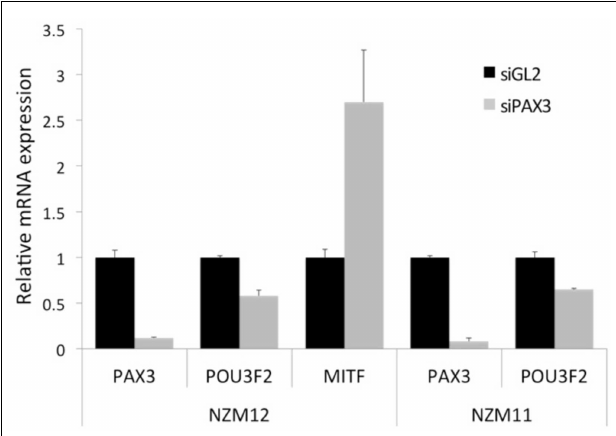
FIGURE 5 | Knockdown of PAX3 results in a decrease of POU3F2 and an increase of MITF gene transcript levels in melanoma cell lines in vitro . Transcript levels of PAX3 , POU3F2 , and MITF mRNA were examined by RT-qPCR in NZM12, and in NZM11 ( PAX3 and POU3F2 only) melanoma cell lines following RNAi treatment of the cell lines with either siRNAs against luciferase (siGL2) as a negative control, or against PAX3 (siPAX3).The results were calculated as the fold difference in transcript level relative to the level of the housekeeping gene GNB2L1 , normalized to the siGL2 data.